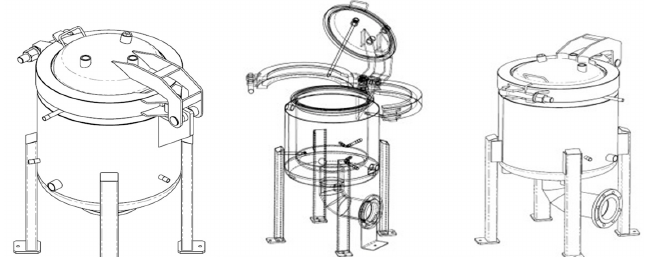
Figure 2. Pressure vessel (120 L) with overpressure ammonia stripping nozzles constructed for the purpose of the experiment. The inner vessel resists up to 2000 kPa. Outer layer contains thermal-oil bath with three 1000 W thermostatically regulated electric heaters, which heats the inner vessel. Diluted slaughterhouse waste was heated to 130 °C and air stripped with constant air flow of 144 NL/min under selected pressures, 300, 600, and 900 kPa.